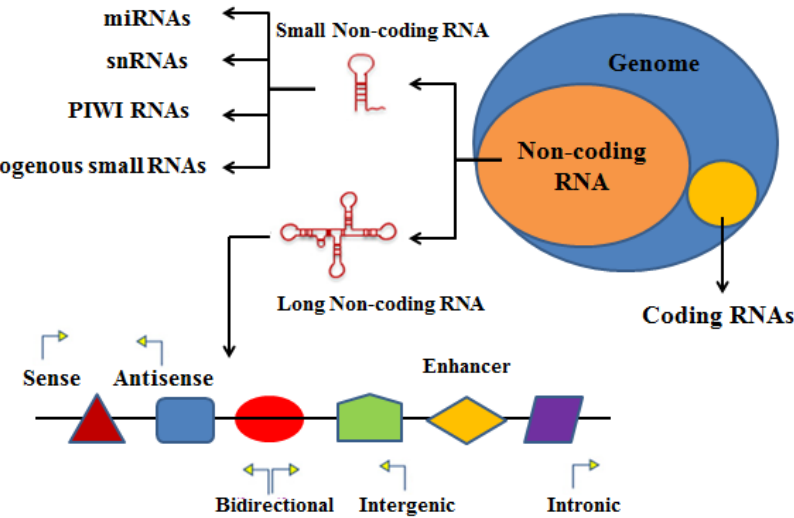
Figure 2. Noncoding RNAs classified into small noncoding RNAs and long noncoding RNAs. Small noncoding RNAs include miRNAs (microRNAs), snRNAs (small nucleolar RNAs), PIWI-interacting RNAs, and endogenous small interfering RNAs. Long noncoding RNAs (lncRNAs) are composed of sense, antisense, bidirectional, enhancer, intergenic, and intronic lncRNAs based on their localizations as compared to the nearby protein-coding genes. LncRNAs could function as competing endogenous RNAs (ceRNAs).